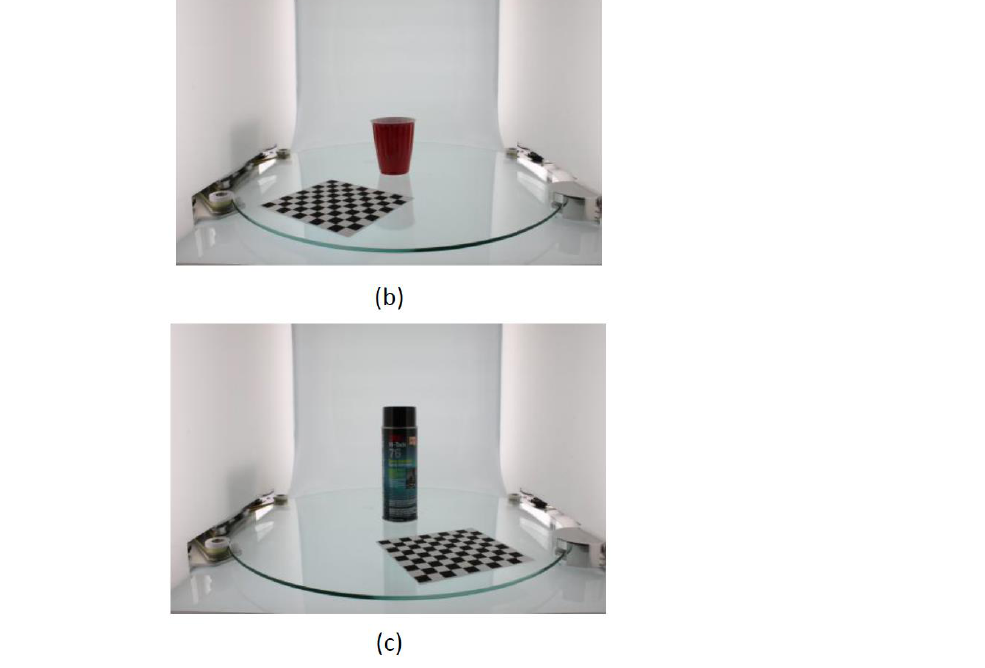
Figure 4. Dataset for experiment [18]: ( a ) ikea_table_leg_blue; ( b ) ikea_table_red_cup; ( c ) 3 m_high_tack_spray_adhesive.